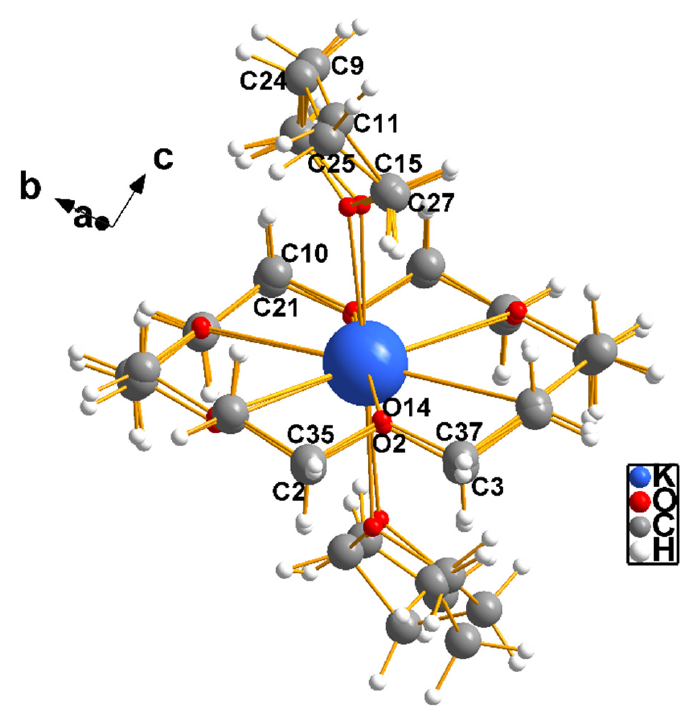
Figure 8. As is obvious, the potassium cations and the crown ether ligands fit almost exactly on top of one another; remarkably, even the alkyl hydrogens fit. The main discrepancy in the fit is associated with the axial furan ligands, despite the best efforts of Mercury [5] to fit them using least-squares fitting. This failure is particularly evident in the furan ring at the bottom of the figure, and it is this poor fit and the other more minor misfits that account for the fact that Z’ = 2.0, and that the crystal is a kryptoracemate [7–11].